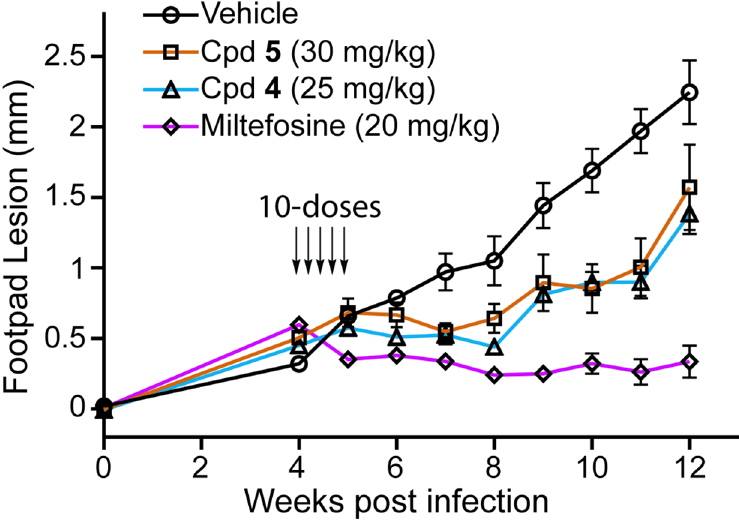
Fig 5. In vivo efficacyfor controlling cutaneous lesion progression in the mouse. Mice (5 per cohort) were infected with L . mexicana promastigotes on day 0; by week 4 after infection, cutaneous lesionshad grown to ~0.5 mm width. Compound 4 (triangles),compound 5 (squares), or miltefosine(diamonds) were delivereddaily by oral gavage for 10 sequential days. One cohort of mice (circles) received vehiclealone. Measurements are plotted as the mean ± standard